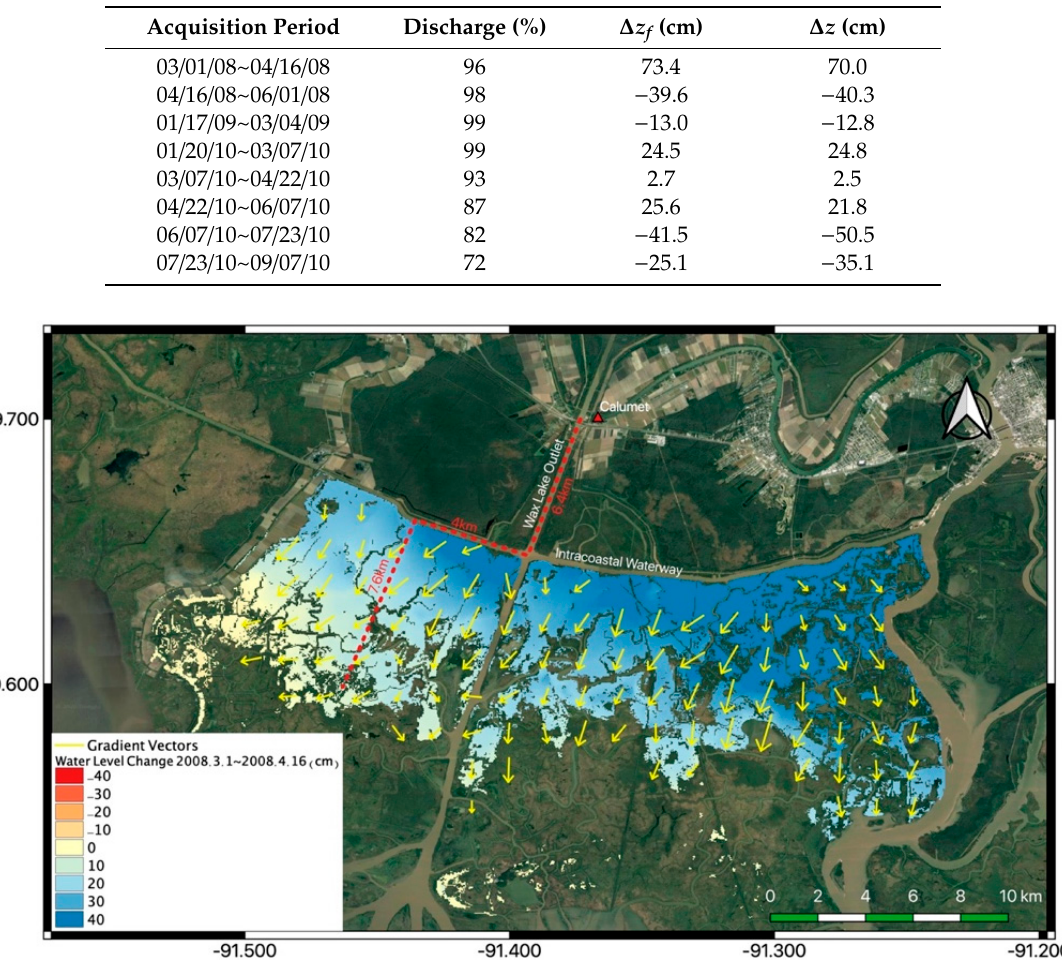
Figure 17. The gradient for water level change map estimated from the pair 2008.3.1 to 2008.4.16, over swamps. The arrows are the inferred flow direction parallel to the steepest water-level change gradient. The red dashed lines are an example of the covered distance of flooding from Calumet, 18 km. (Background Map from Google [26]).